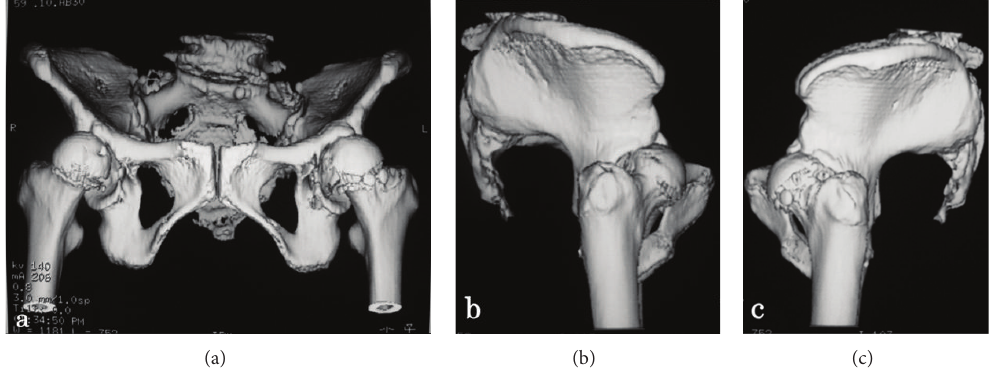
Figure 3: Three-dimensional computed tomography (3DCT) with an anteroposterior view (a) and lateral views of the right (b) and left (c) sides of the bilateral hip joint. 3DCT confirmed anterior subluxation of both femoral